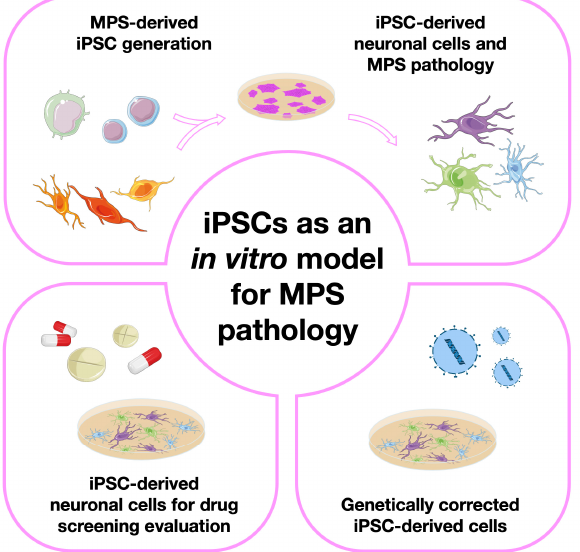
Figure 1. The four major types of studies involving the generation and characterization of induced pluripotent stem cells (iPSCs) as in vitro models for Mucopolysaccharidoses (MPSs), grouped together according to their ultimate aims: (1) papers on iPSC generation and characterization; (2) papers describing their subsequent differentiation into different types of neuronal cells; (3) papers on the use of iPSCs and their derived cell models for drug screening; and (4) papers on the use of genetically corrected iPSCs for therapeutic purposes.